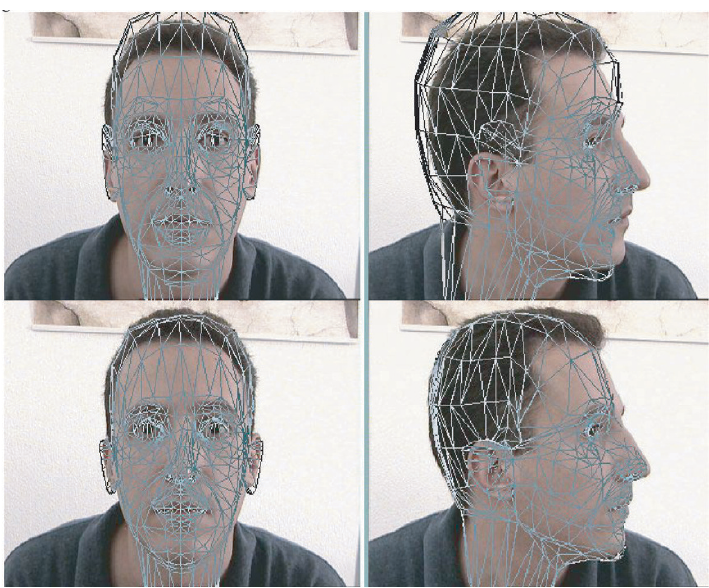
Figure 4: Rigid (upper) and nonrigid (lower) adaptation of the face model on the front and profile views.